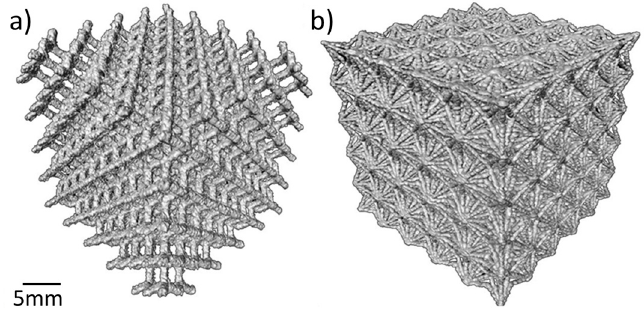
Figure 2. Examples of reconstructed CT volumes of ( a ) diamond-like and ( b ) re-entrant cube lattice structures. (CT: X-ray computed tomography.)